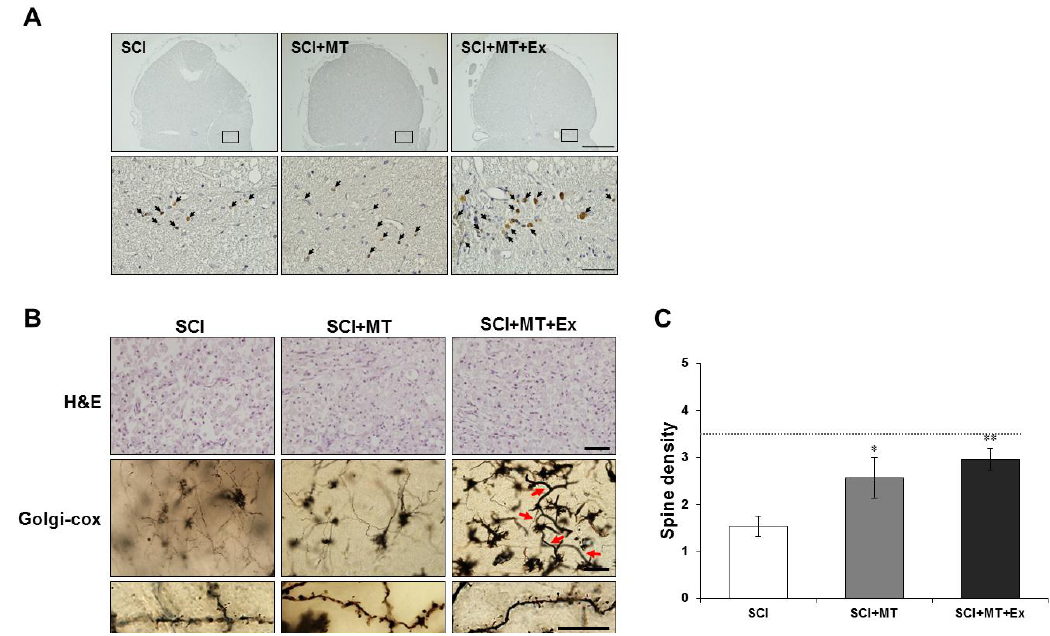
Figure 2. Effect of therapeutic interventions of melatonin and melatonin combined exercise on damaged architectures after spinal cord injury. ( A ) Melatonin combined with exercise increased the BrdU-positive cells, but melatonin did not show a synergistic effect on dividing cell proliferation at day 21 after SCI. Representative cross sections taken 1 mm rostral to the epicenter from SCI, SCI+MT, and SCI+MT+Ex rats, respectively. Immunohistochemistry was performed for BrdU at day 21 after injury. Nuclei were counterstained with hematoxylin. Scale bar = 0.5 mm (upper panel), 50 µm (lower panel). ( B ) Spinal cord tissues at day 21 after injury were observed by H & E staining (upper panel) and Golgi-cox staining (middle and lower panel) at high magnification within the cyst in all groups. Scale bar = 50 µm. ( C ) Quantification of spine density (number of spines/µm) in all groups. The gray dotted line indicates the dendritic spine density for the non-SCI control.Comparisons were made using one-way (ANOVA) with SPSS software and the post hoc Tukey’s tests. Data are expressed as the mean ± SEM. (* p < 0.05, ** p < 0.01 vs.